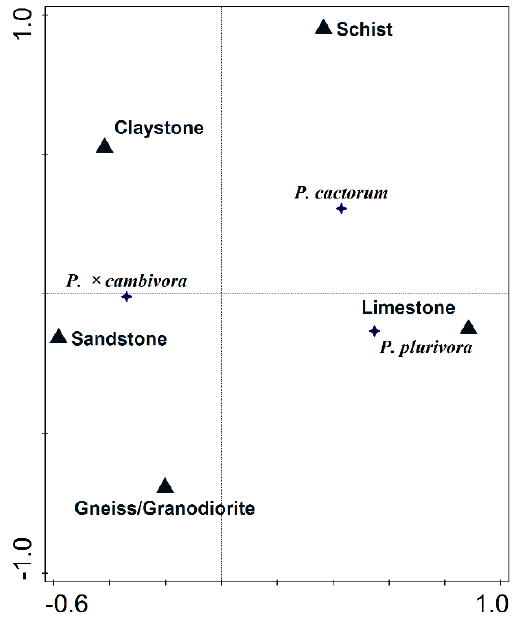
Figure Figure 4. Canonical correspondence analysis (CCA) of Phytophthora community structure (CAC = P. cactorum , CAM = P. × cambivora , PLU = P. plurivora ) according to the geological substrate in 34 beech stands in Lower Austria.